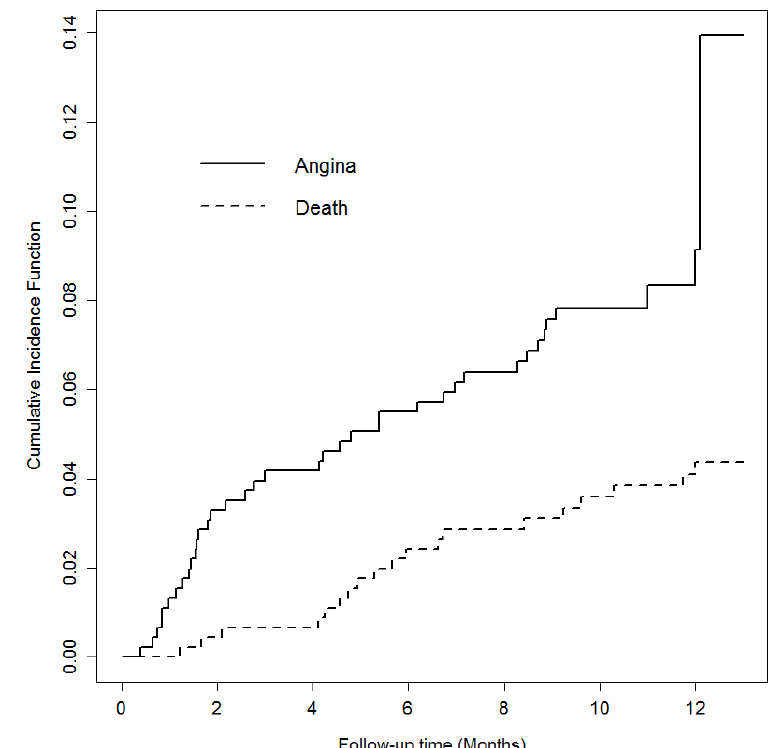
Figure 1. Curves of the cumulative incidence of events.